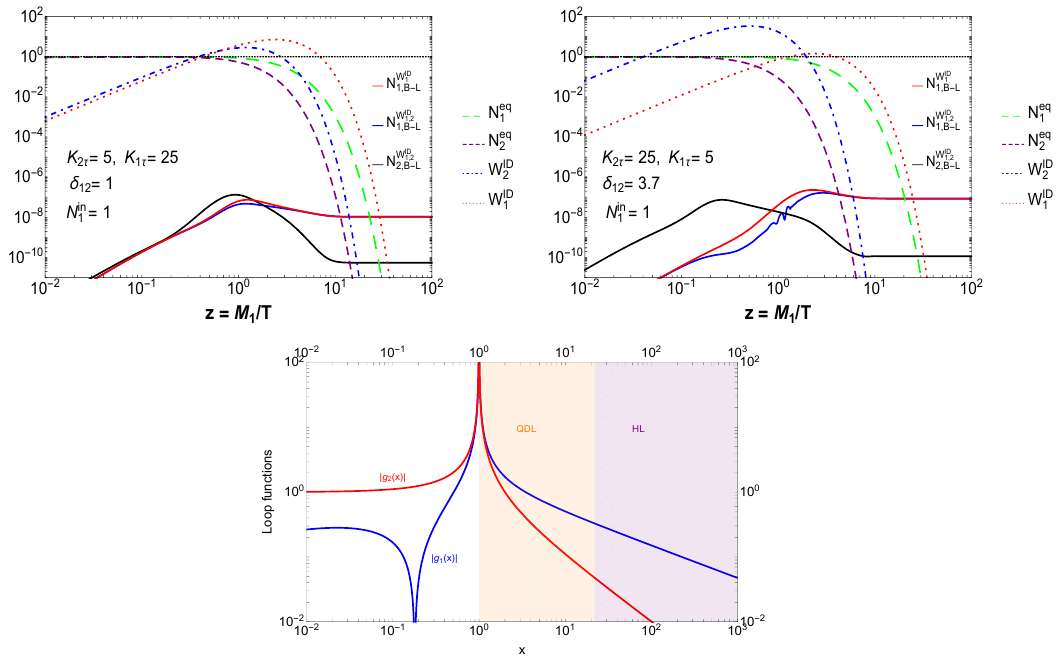
Figure 9 . Upper panel: (Colour codes for the N B (cid:0) L asymmetries are same as (cid:12)gure 1): repre- sentative plots showing the validity of N 1 dominated scenario when the decay parameter of N 2 is weaker than the decay parameters of N 1 (left), and vice-versa (right). Bottom panel: variation of the involved loop functions in the CP asymmetry parameters. The light violet region is the region where hierarchical scenario is valid in the model under